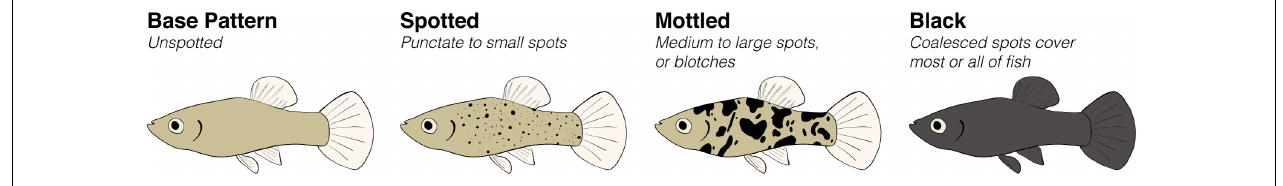
FIGURE 2 | Representation of the poeciliid pigmentation patterns included in this review. The base pattern lacks macromelanophores, so we interchangeably refer to it as “unspotted.” Melanic side-spotting patterns include any pattern in poeciliid fishes that consists of macromelanophores forming spots that are irregularly distributed on the fish’s flank. Included melanic side-spotting patterns may also extend into fins or be restricted to only a portion of the flank, not pictured here. The black morph is an extreme version of the spotting